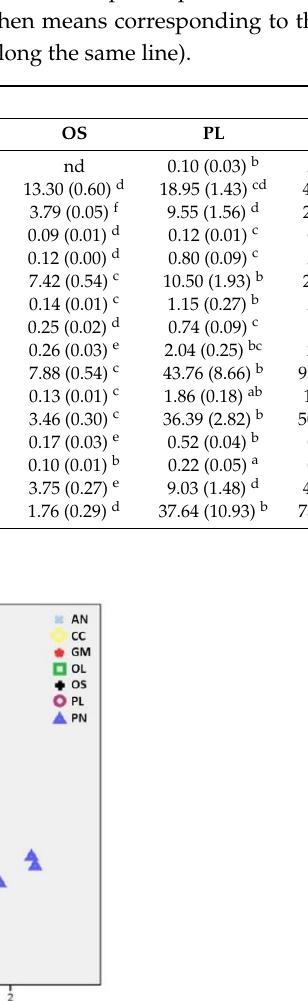
Table 1. Elements’ concentrations in the cultivation substrates used for the production of Cyclocybe cylindracea and Pleurotus ostreatus mushrooms. AN: almond and walnut shells 1:1 w / w ; CC: corn cobs; GM: grape marc plus cotton gin trash 1:1 w / w ; OL: olive mill by-products (leaves and two phase olive mill waste 1:1 w / w ); OS: extracted olive press cake; PL: date palm tree leaves; PN: pine needles. Values